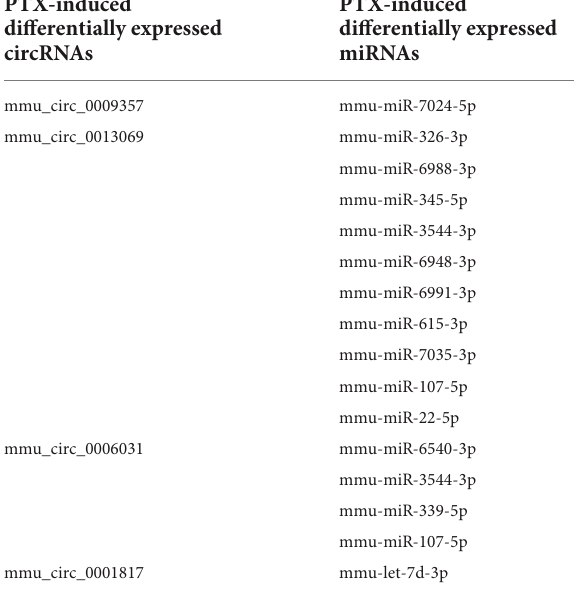
TABLE 6 CircRNA and miRNA interaction predicted by CircMir software. PTX-induced differentially expressed circRNAs